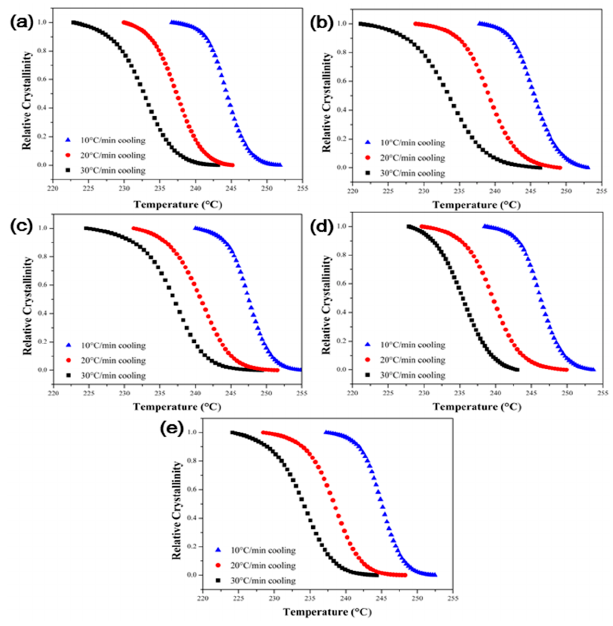
Figure 8. Plots of relative crystallinity versus temperature of the PPS/MWCNTs composites at